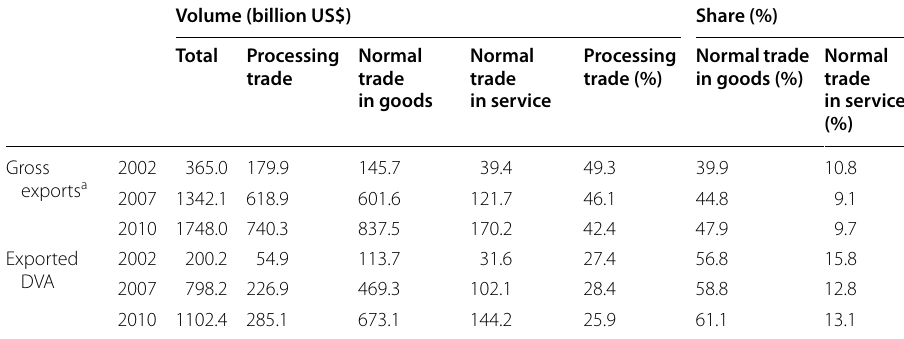
Table 2 Gross exports and DVA of exports from China in 2002, 2007, and